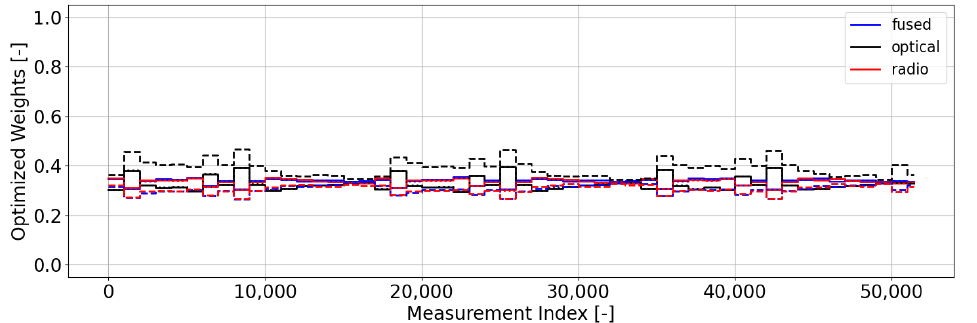
Figure 16. Optimal gating network weights with radiometric measurement biasing. Small (solid lines), medium (dotted lines), and large (dashed lines) biasing cases are